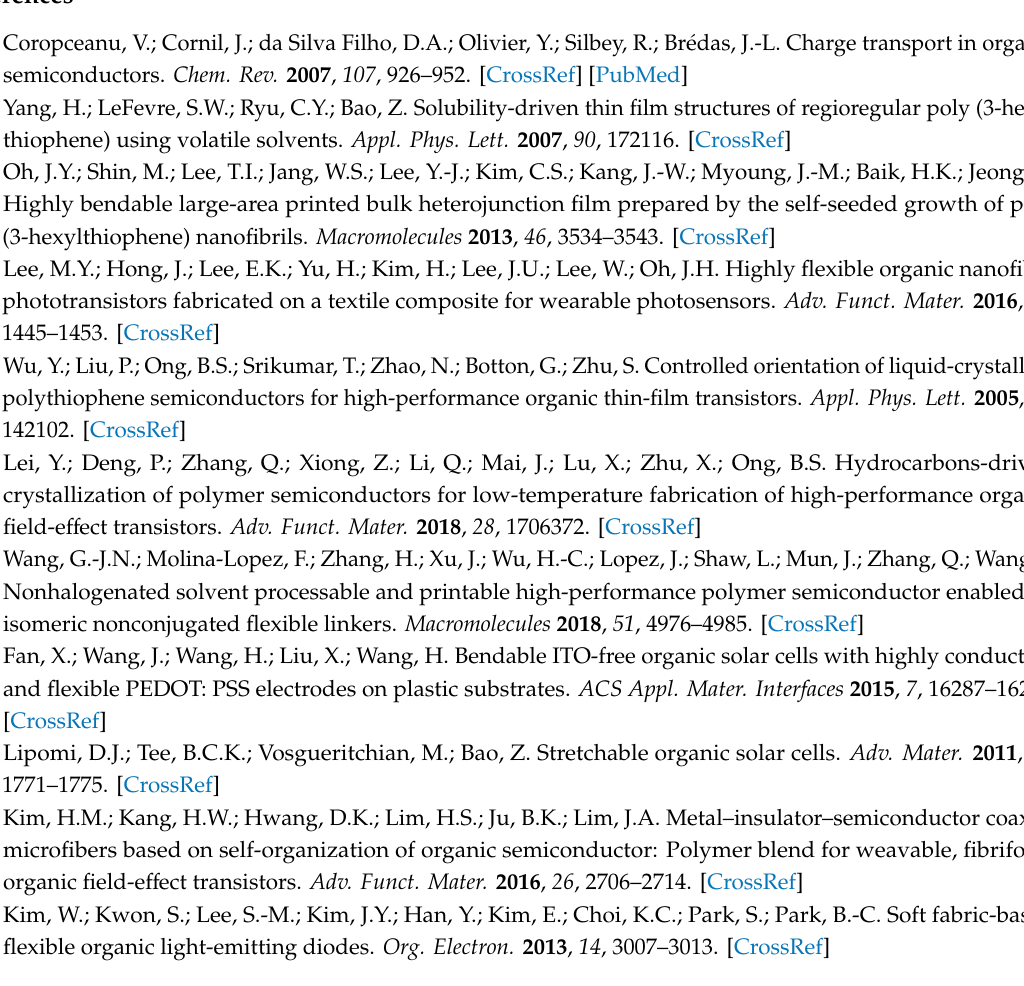
Figure S1: Photo images of the bended sample at fixed dL / L = 50% in the SEM chamber, Figure S2. Optical image of aggregation of P3HT / EEG 20 nanocomposite solution, Figure S3: Transfer characteristics of OFET devices based on the P3HT / EEG 10 nanocomposite film at 0 (after transfer process), 200, 400, 600, 800 and 1000 cycles of bending